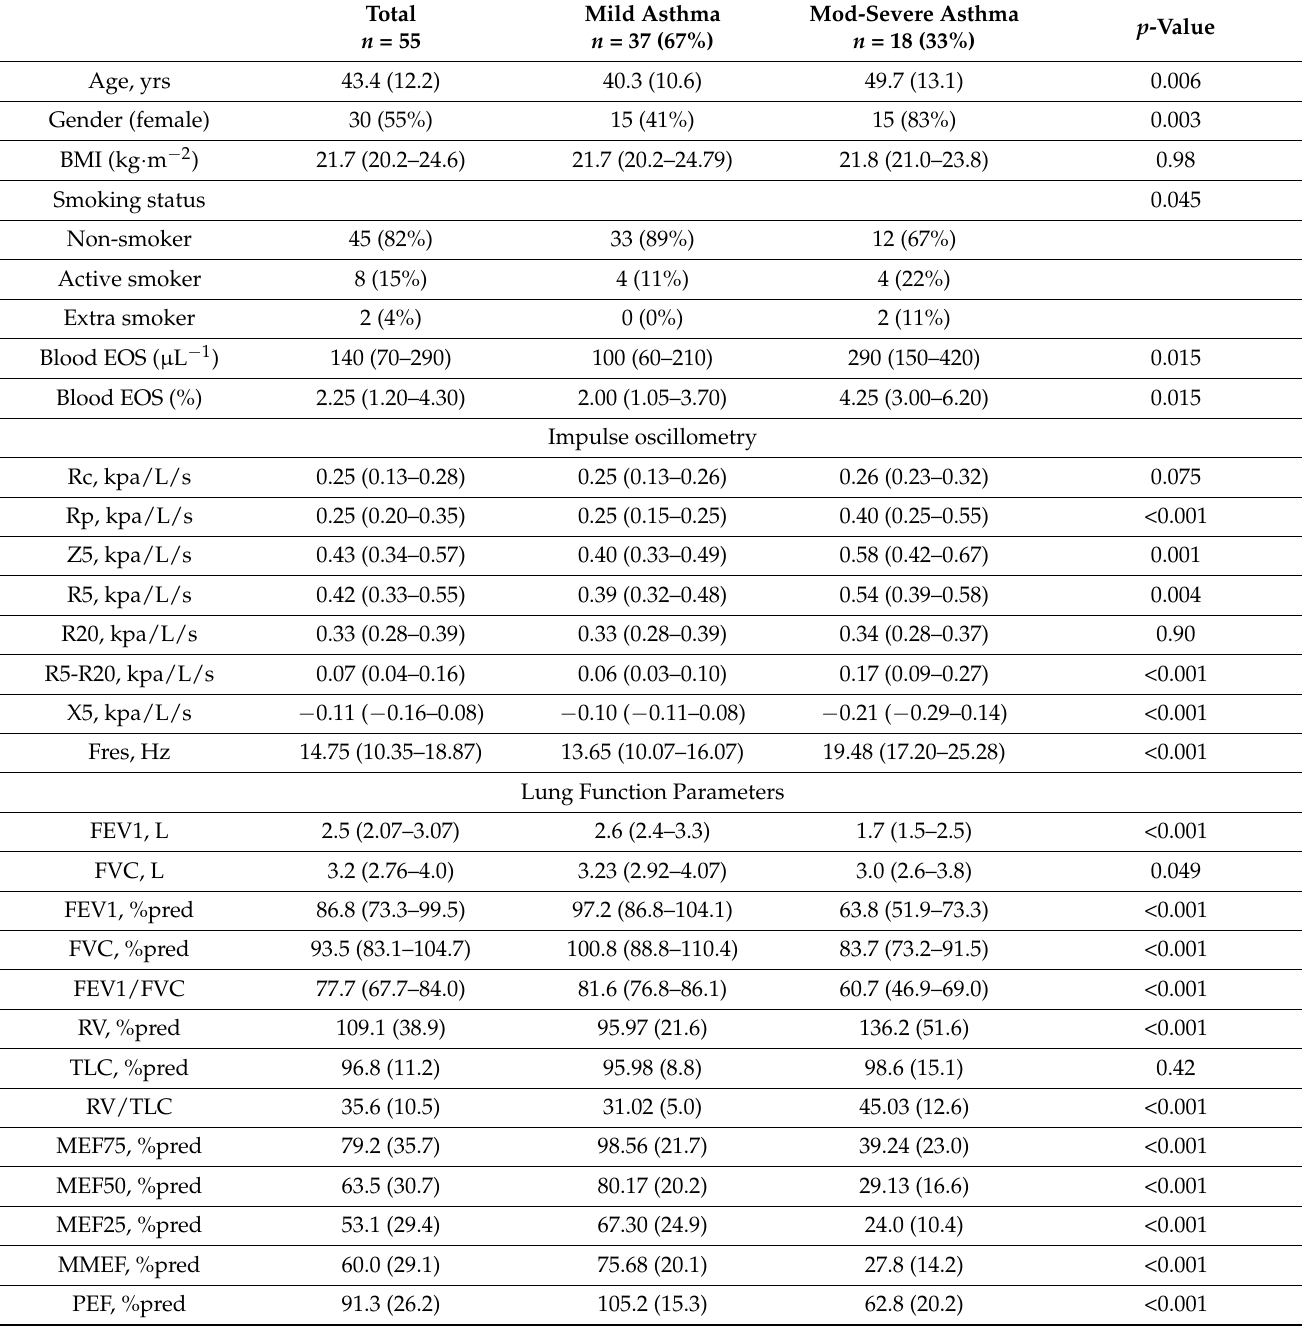
Table 1. Characteristics of asthma patients stratified by disease